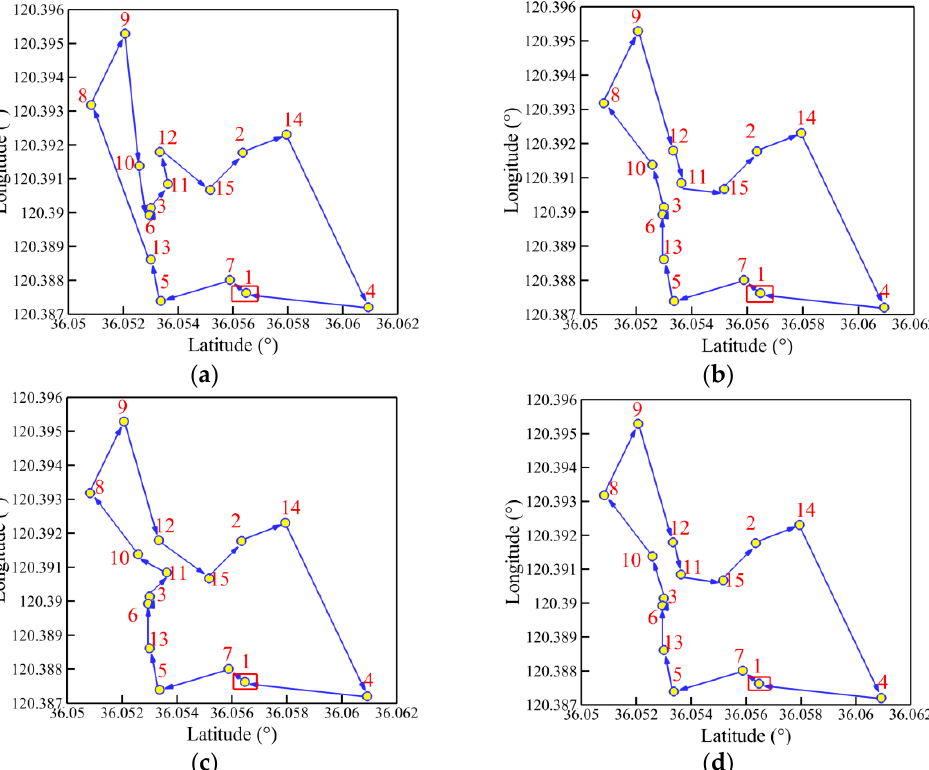
Figure 15. Trajectory planned by each algorithm for P = 15: ( a ) CGA; ( b ) SDIGA; ( c ) DDIGA; ( d ) MDIGA.